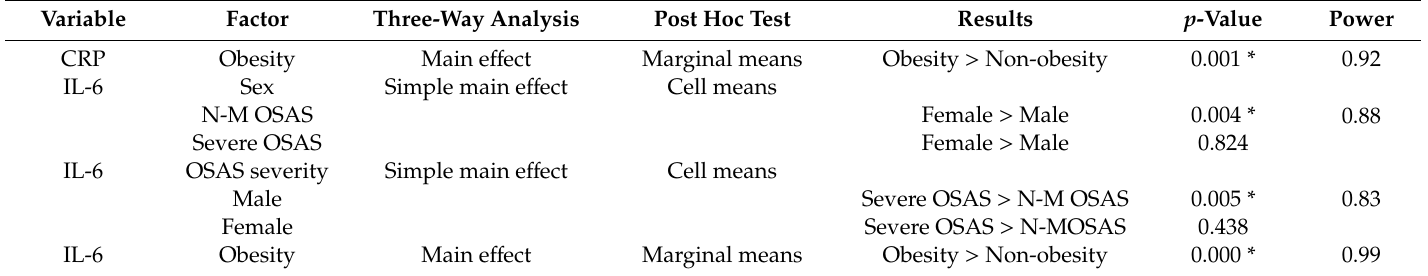
Table 6. Post hoc test (Sche ff e) for the inflammatory biomarkers significantly associated with OSAS severity, sex, and